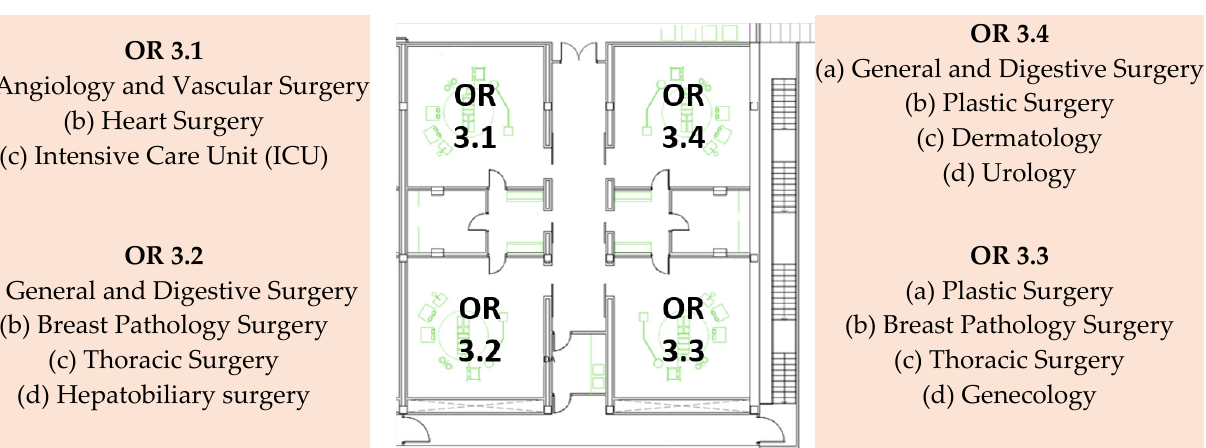
Table 2. Annual Occupancy and Average Surgical Time per OR.